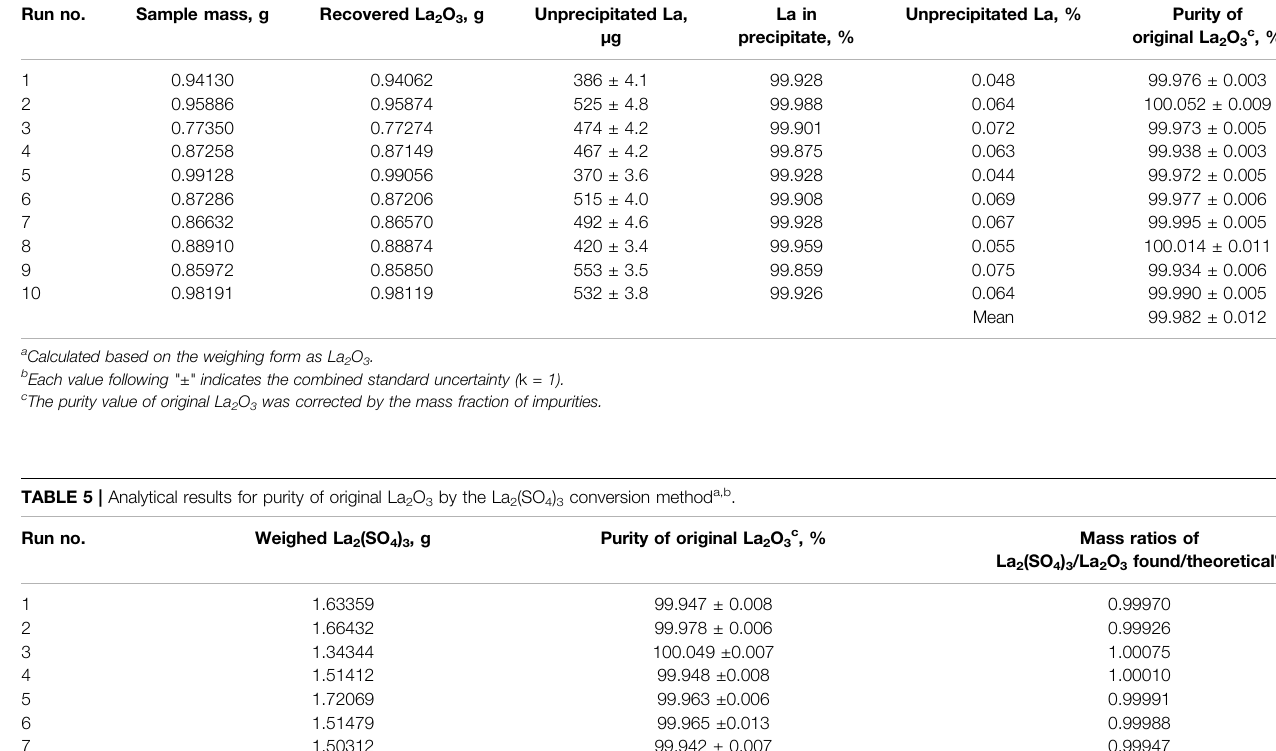
TABLE 4 | Analytical results for purity of the original La 2 O 3 sample by the oxide weighing method a,b . Run no.